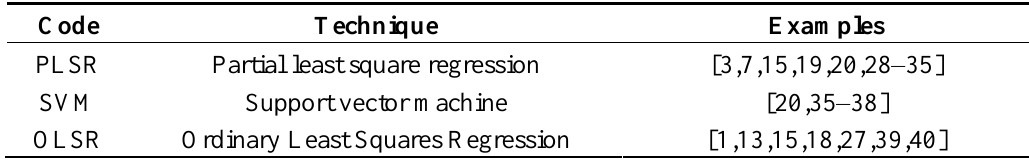
Table 1. Examples of statistical techniques for estimating vegetation biophysical variables from hyperspectral